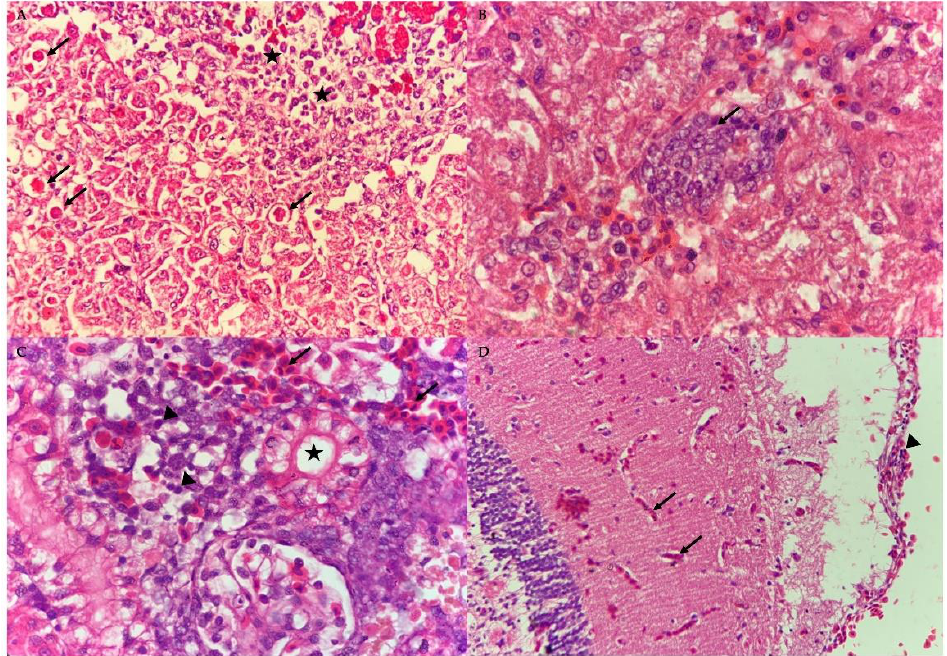
Figure 8. Photomicrograph of the liver, kidney and brain of the naturally co-infected red hybrid tilapia by Tilapia Lake Virus, Aeromonas hydrophila and Streptococcus agalactiae . ( A ) Infiltration of lymphocytic inflammatory cells (stars) and eosinophilic intracytoplasmic inclusion bodies (arrows) in the liver section (40×, H&E). ( B ) Syncytial giant cell exhibiting multiple nuclei (arrow) in the liver section (100×, H&E). ( C ) Mild renal tubular degeneration (star) and haemorrhages (arrows) in the kidney section together with moderate infiltration of mononuclear inflammatory cells (arrow heads) (100×, H&E). ( D ) Mild congestion (black arrows) and infiltration of lymphocytes (arrowhead) in the meninges (40×, H&E).